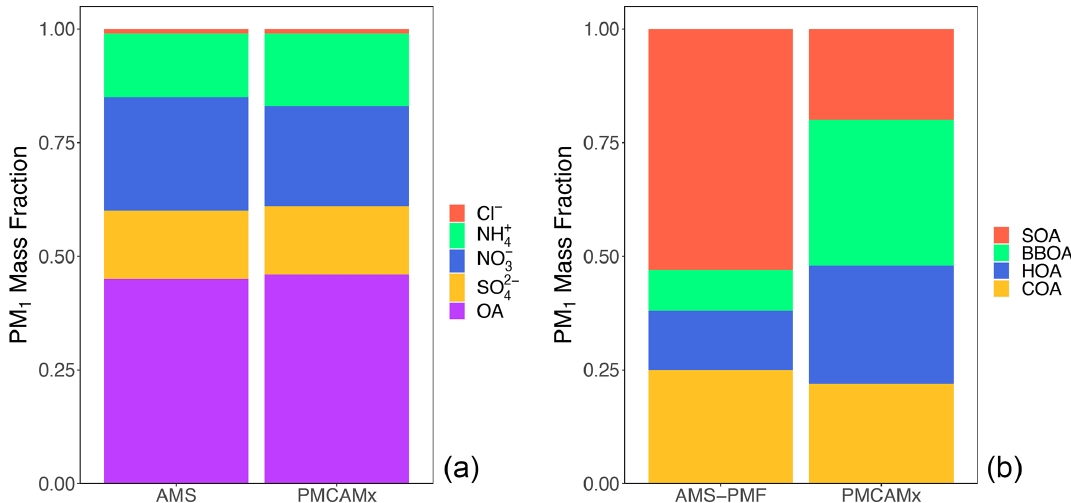
Figure 3. (a) Comparison of PMCAMx-v2.0-predicted composition of PM 1 with the corresponding AMS measurements at the CMU site and (b) organic aerosol composition based on the PMF analysis of the AMS measurements and predicted